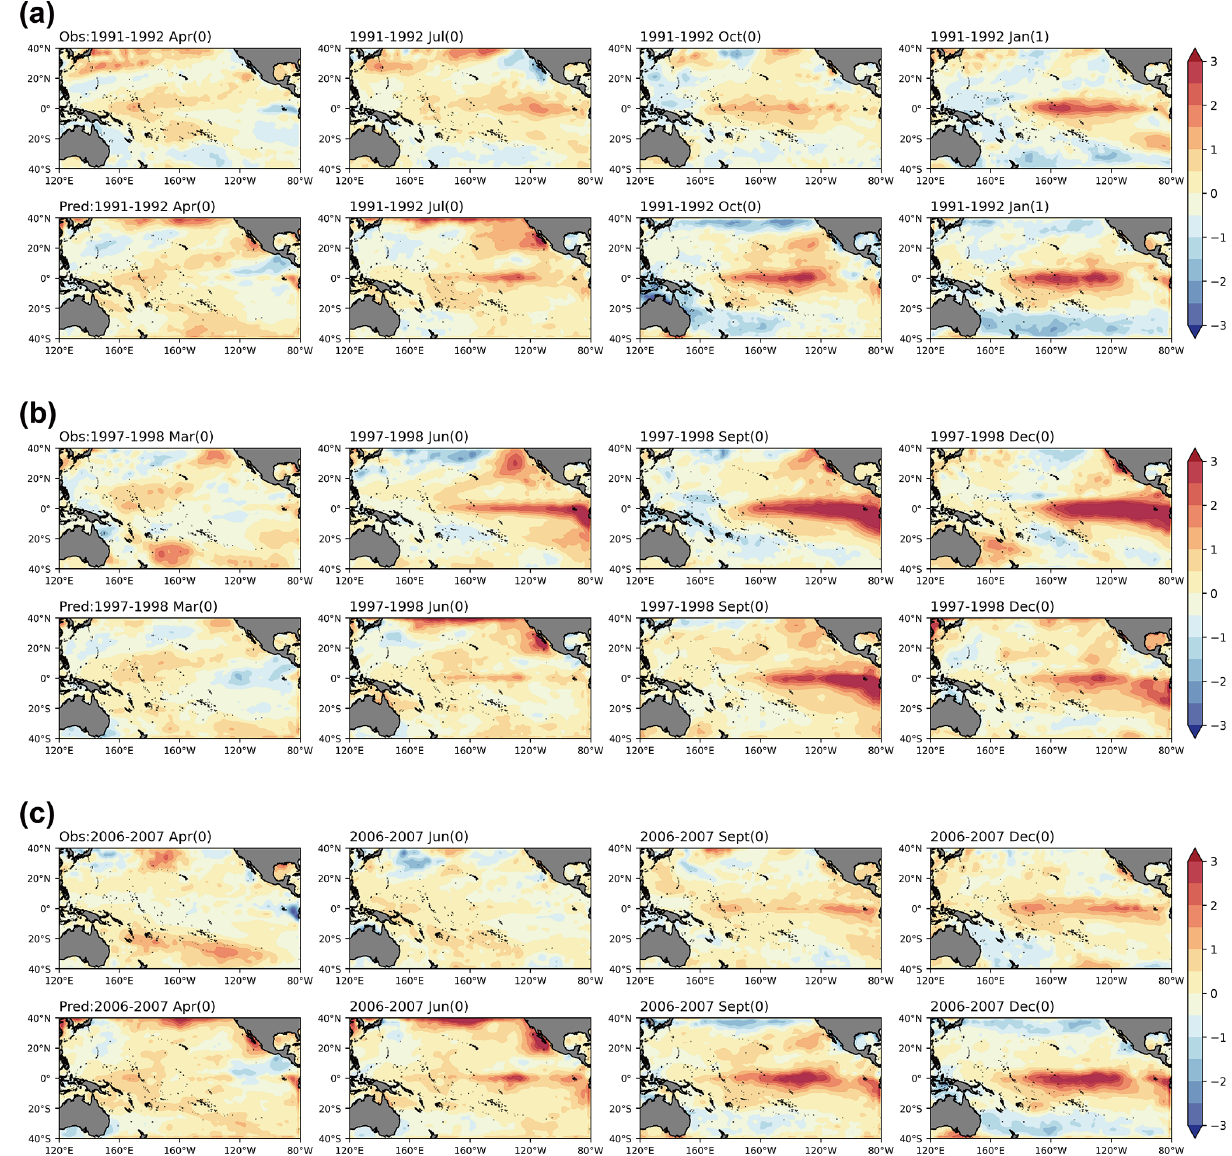
Figure 9. SST anomalies of three EP El Niño events in (a) 1991–1992, (b) 1997–1998 and (c) 2006–2007 from the onset to the maturity stage, with observations in the first row and predictions in the second row for each event. The mature phases here are the months when the El Niño events peak. The “0” and “1” next to the calendar month denote the year when the El Niño event occurred and the following year